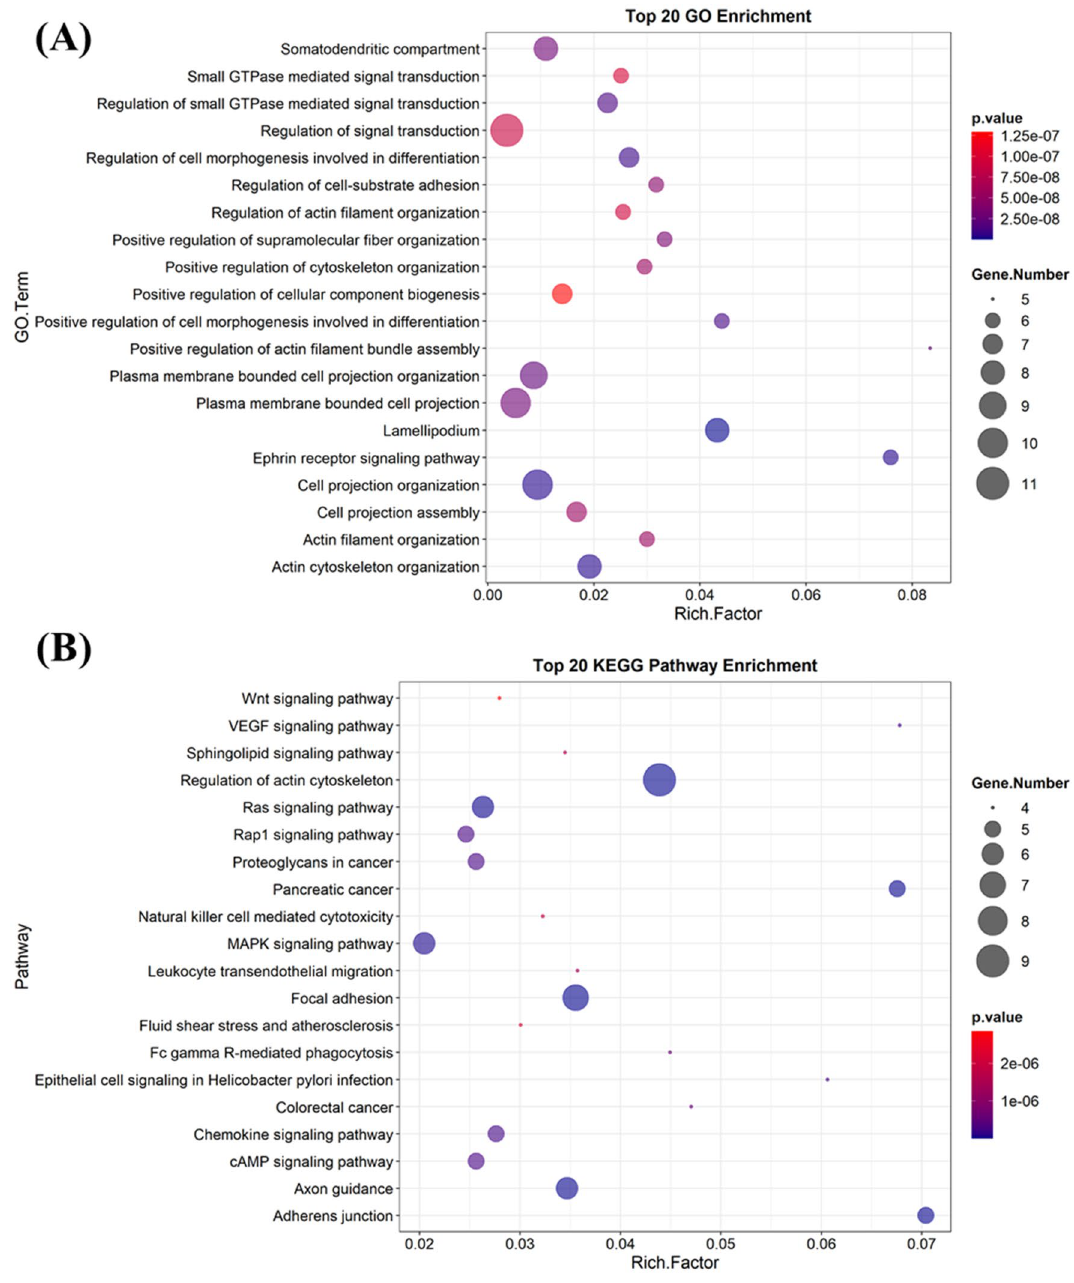
Figure 12. To 20 gene ontology enrichment ( A ) and KEGG pathway enrichment ( B ) analyzed by PAK1 and its other network